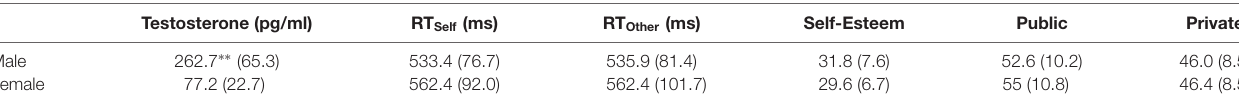
TABLE 1 | The means and standard deviations of hormonal and behavioral